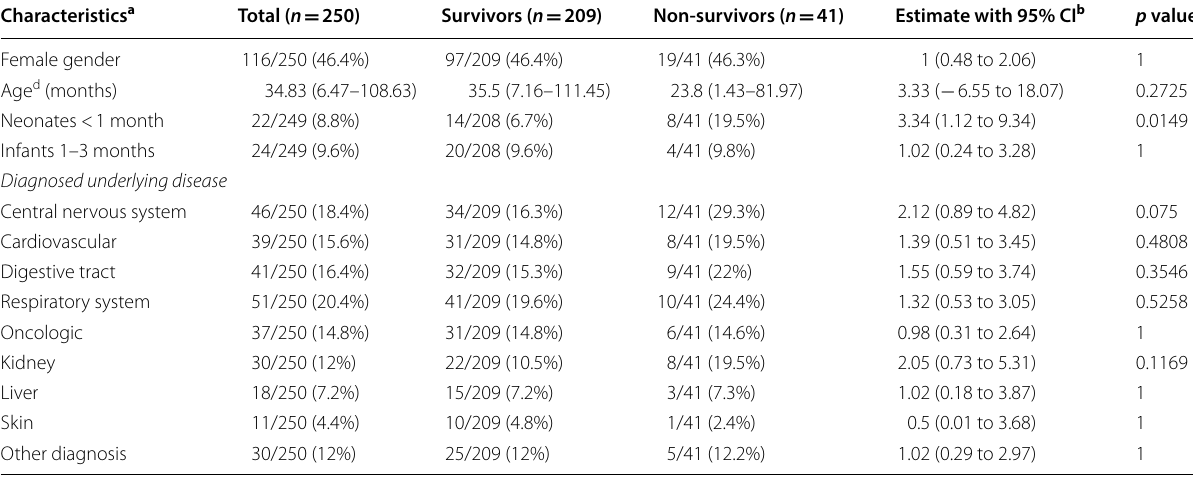
a Binary data are presented as no./total no. (%) and continuous data as medians (25th–75th percentile) b Odds ratio for binary variables and estimated median difference for continuous variables c Differences between survivors and non-survivors assessed with Fisher’s exact test for binary variables and Wilcoxon rank sum test for continuous variables